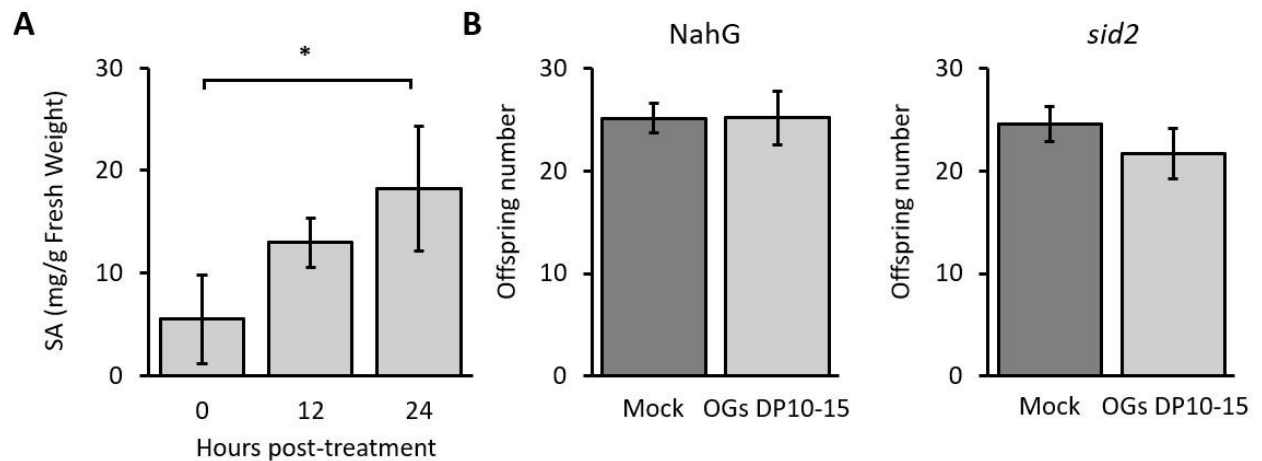
Figure 6. OG-induced resistance against aphids requires SA accumulation. ( A ) SA content measured in Arabidopsis leaves treated with OGs (DP 10–15) at 0, 12, and 24 hpt ( n = 3). Asterisk represents significant differences found using Student’s t -tests (*, p < 0.05). ( B ) No-choice assay performed with NahG and sid2 Arabidopsis genotypes deficient in SA accumulation. Fully expanded leaves of 4-week- old Arabidopsis plants were infiltrated with OGs (DP 10–15; 200 µ g mL − 1 ) or ultrapure water (mock). One-day-old nymphs were confined to treated leaves of both NahG and sid2 plants, and 12 days after treatment, the number of offspring was counted. Using Student’s t -test, no significant differences were found between the number of offspring deposited by aphids on mock- and OG-treated NahG and sid2 plants. At least six replicates were assayed for each